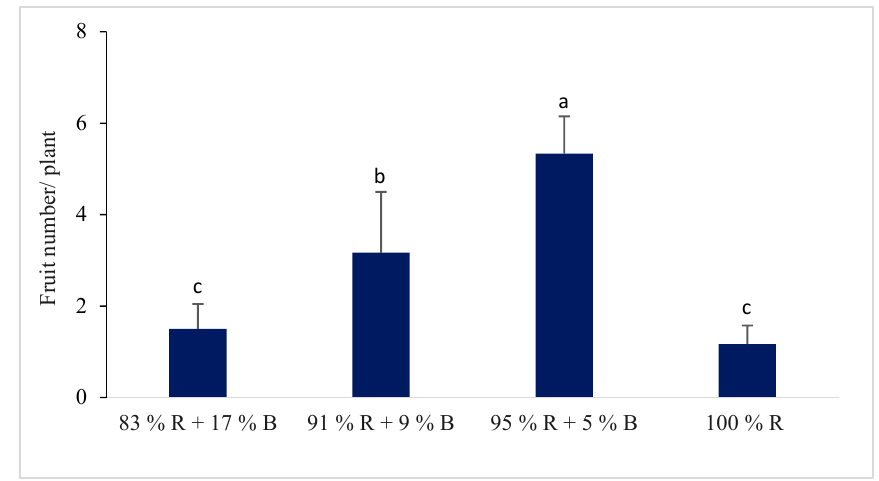
Figure 3. The effect of different percentages of red (R) and blue (B) LEDs on the fruit number of the sweet pepper. Bars represent the standard deviation (n = 6). Values with different letters are significantly different from each other ( p < 0.05).